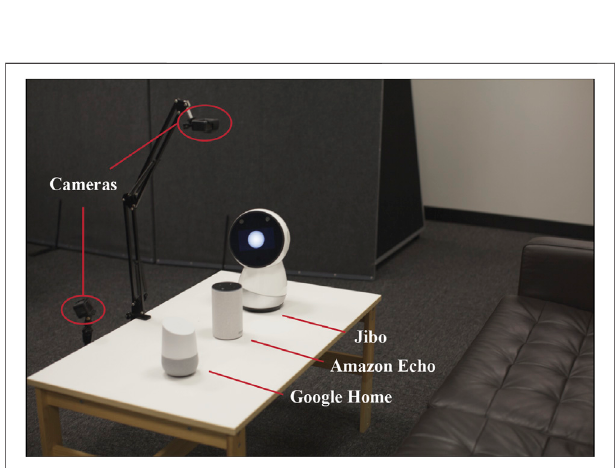
FIGURE 3 | Example study setup with three commercially available at- homeVUIs(Jibo,AmazonEcho,andGoogleHomefromStudy1and2shown here) and two cameras for recording the interactions and activities. The same study setup was used for each elicitation study with the varying VUIs.